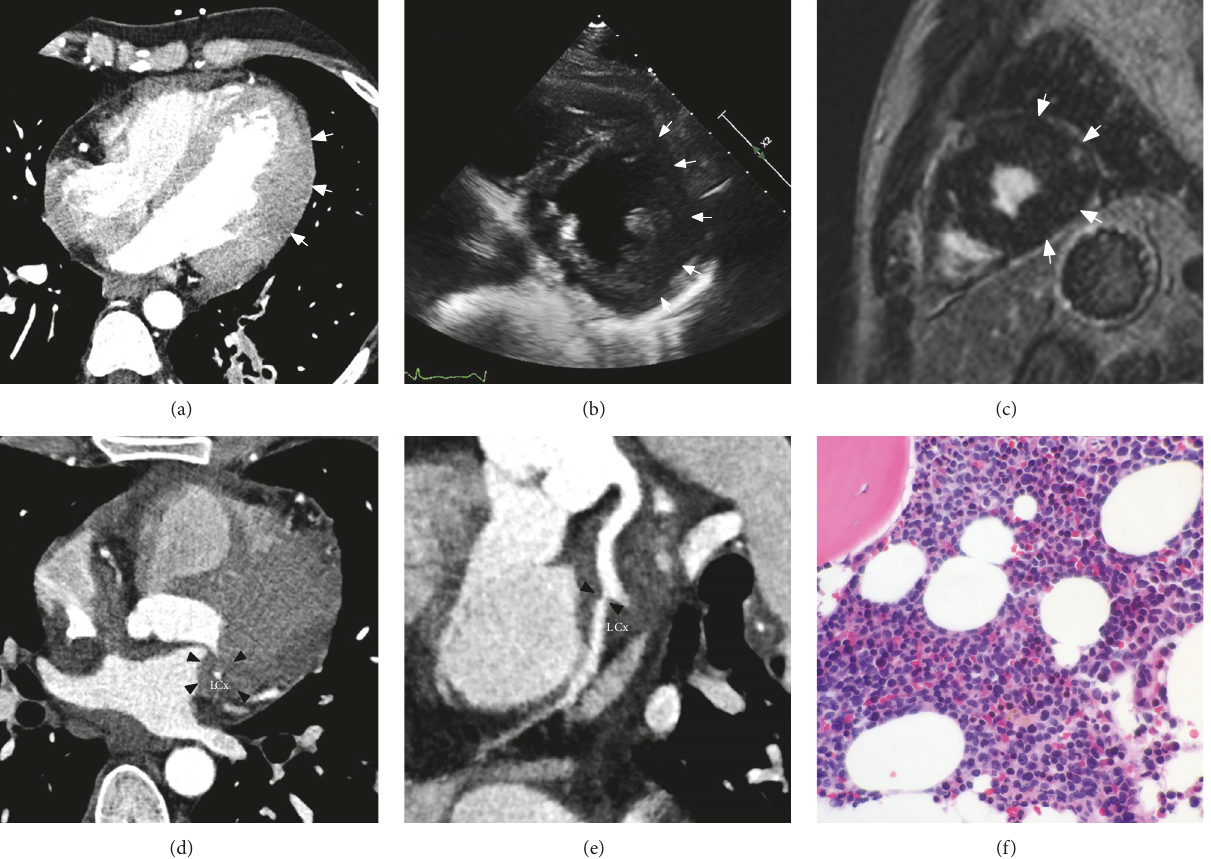
Figure 2: (a) Axial coronary computed tomography angiogram (CCTA), (b) echocardiogram, and (c) CMR with delayed myocardial enhancement images demonstrate marked asymmetric thickening of the lateral left ventricular wall (arrows) . There is obliteration of left ventricular pericardial fat on CCTA. (d) Axial and (e) curviplanar reformatted CT images of the left circumflex artery (LCx) show abnormal soft tissue in the left atrioventricular groove (arrowheads) resulting in approximately 50% stenosis of the LCx immediately after the takeoff of the first obtuse marginal branch. (f) Bone marrow biopsy slide demonstrates replacement of normal hematopoietic elements by small lymphoblasts comprising approximately 50% of total cellularity, compatible with leukemia